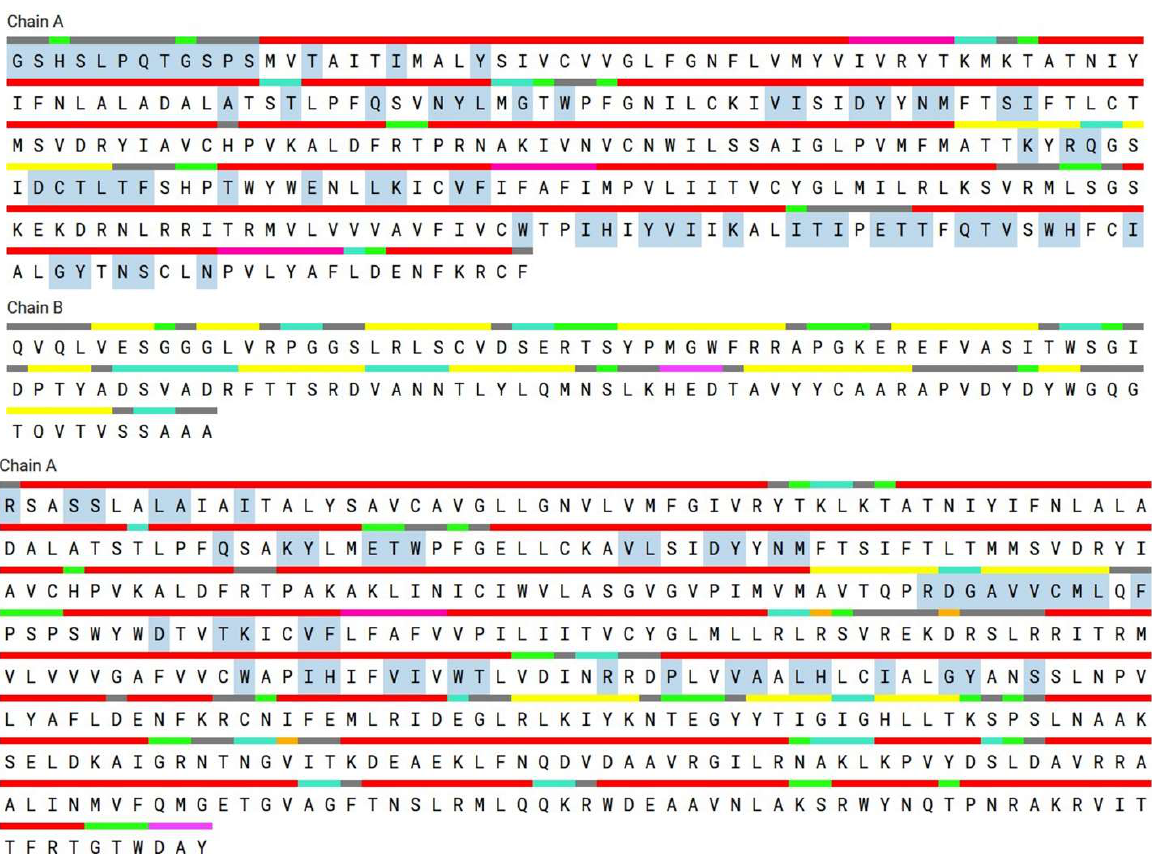
Figure 1. Active sites of 5C1M and 4EJ4 protein found through CASTp server. The location of the ligand inside the protein-binding site was mapped using Autogrid. The dimensions (angstrom) for the 5CIM protein were determined to be X: 24.0000 Å, Y: 32.0001 Å, and Z: 31.0214 Å, and for the 4EJ4 protein, they were determined to be X: 64.0289 Å, Y: 41.9033 Å, and Z: −9.80663 Å. This investigation thus resolved a center coordi- nate of X: 2.0000 Å, Y: 21.1256 Å, and Z: −64.2055 Å for 5CIM and X: 24.0000 Å, Y: 24.0000 Å, and Z: 24.0000 Å for 4EJ4 protein. The docking procedure was run with the standard ex- haustiveness setting of 8. The postures with the lowest binding energy (kcal/mol) were cho- sen from the docking results for 5CIM and 4EJ4 and then visualized using Discovery Studio.